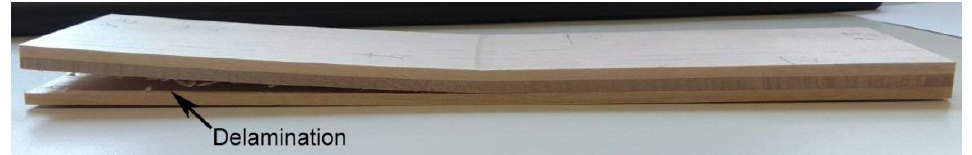
Figure 3. Delamination in the low-density polyethylene (LDPE)-bonded plywood samples during the determination of bending strength.